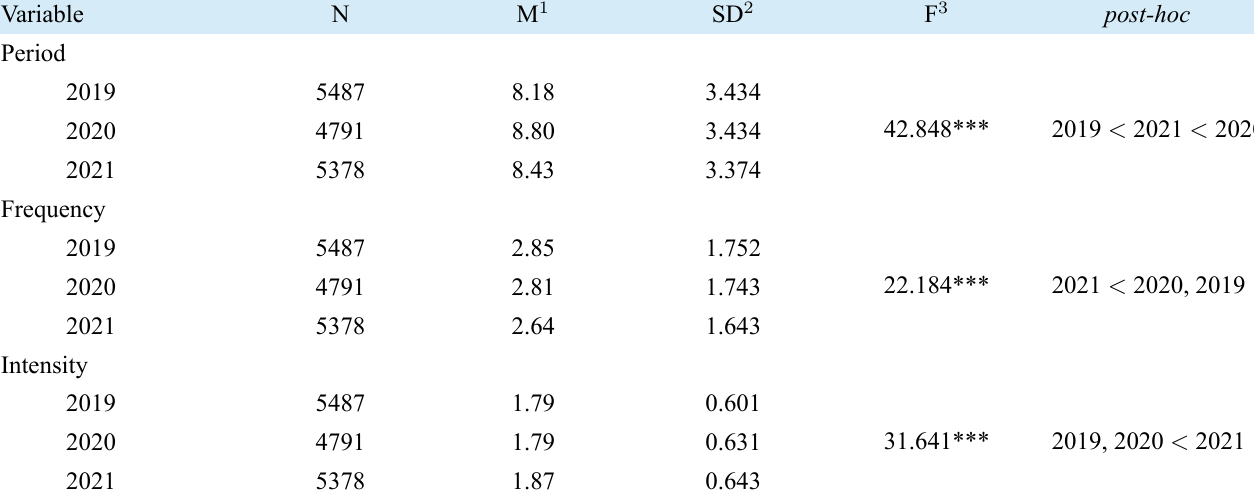
TABLE 3. Changes in the level of sports participation by year